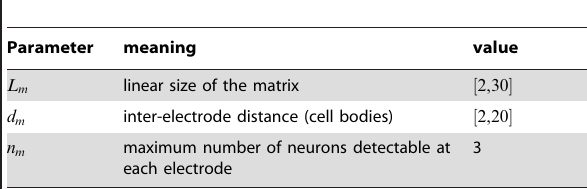
Table 1. Parameters of the model. Table 2. Parameters of the sampling matrix.